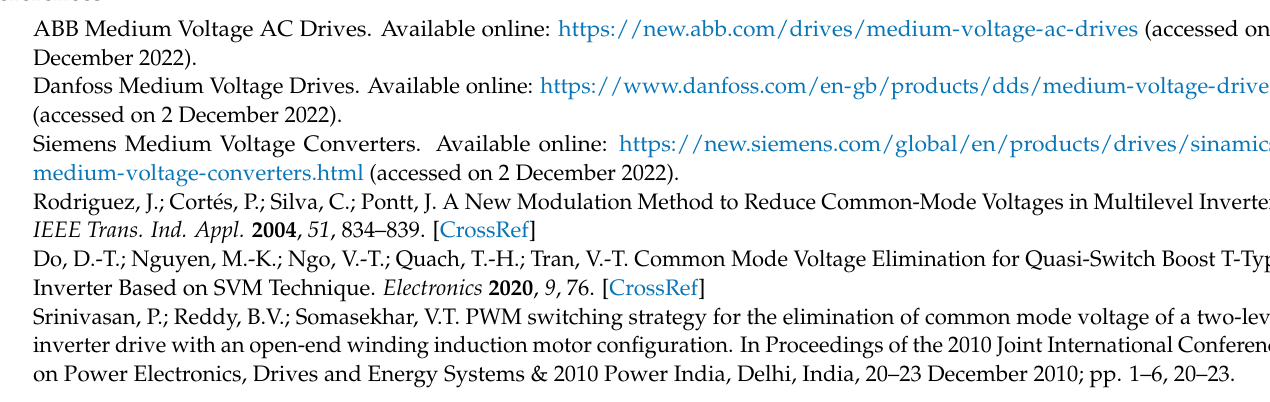
Figure 8. Inverter efficiency as a function of the speed.